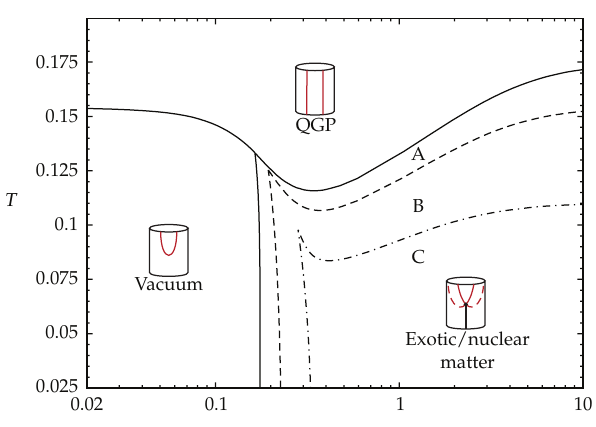
Figure 5: The phase diagram of deconfined nuclear matters in the Sakai-Sugimoto model. Multiquark phase is shown as the region on the lower right corner where it is divided into 3 parts according to the value of the colour strings n s . A , B , C represent the region where multiquark phase with n s (cid:8) 0 (cid:3) N c - baryon (cid:4) , 0.1, 0.3 is the most thermodynamically